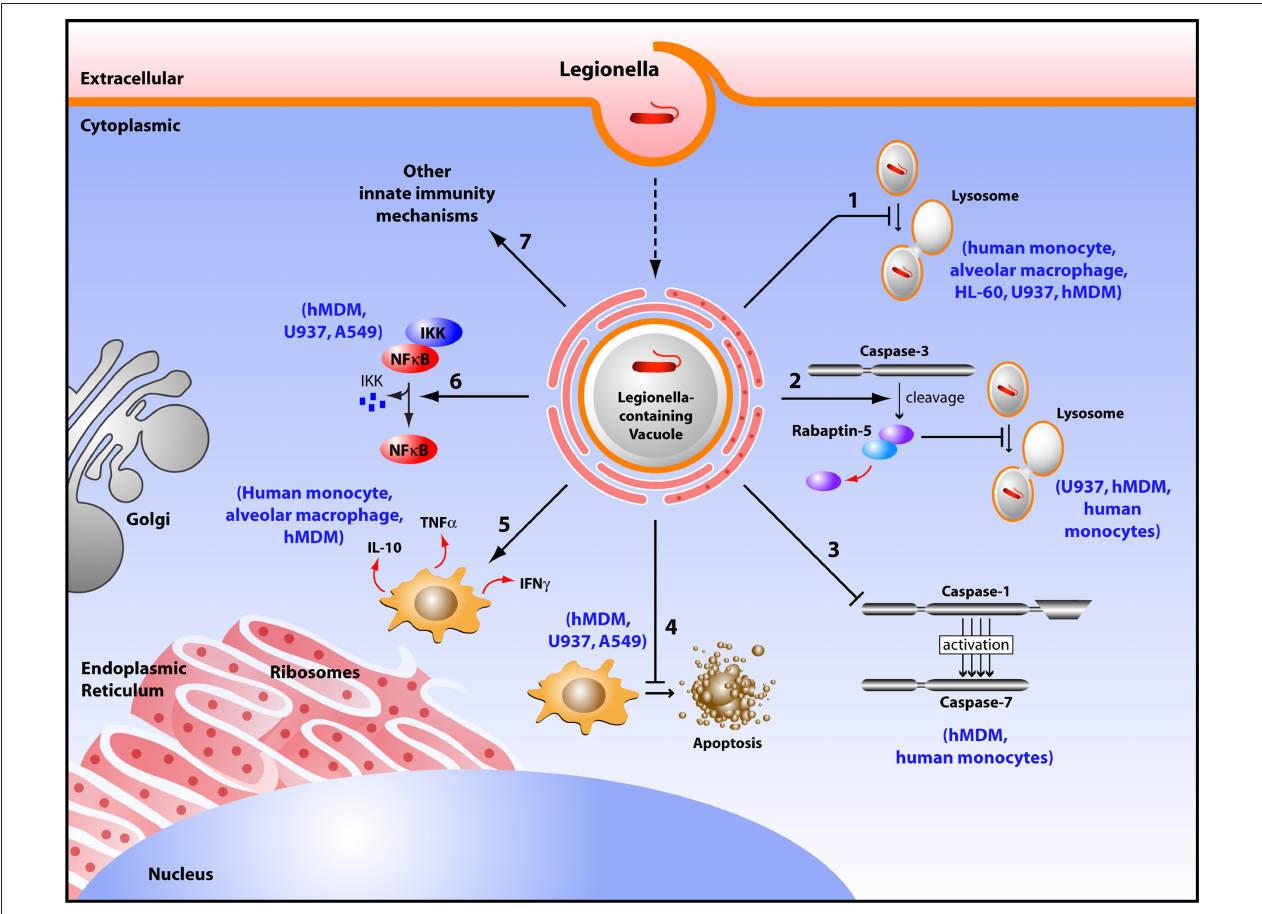
Figure 1 | Diagram depicting survival mechanisms employed by L. pneumophila in human phagocytes . Upon entry into a human phagocyte, L. pneumophila becomes contained into a vacuole called Legionella -containing phagosome that avoids the typical fusion with the lysosome, and instead remodels into an ER-like vesicle allowing bacterial replication (1). L. pneumophila promotes the cleavage of Rabaptin-5 by caspase-3, thus preventing the default phagosome–lysosome fusion (2). L. pneumophila does not activate caspase-1